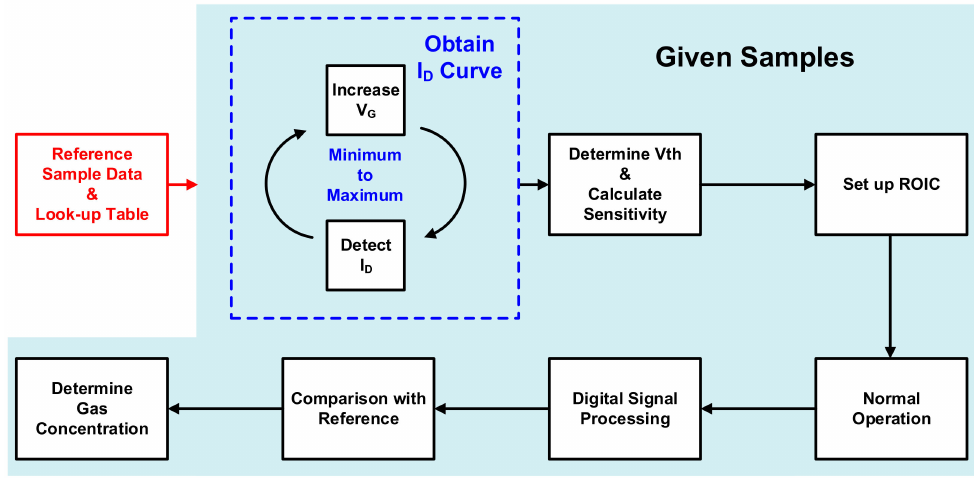
Figure 5. Calibration flow.